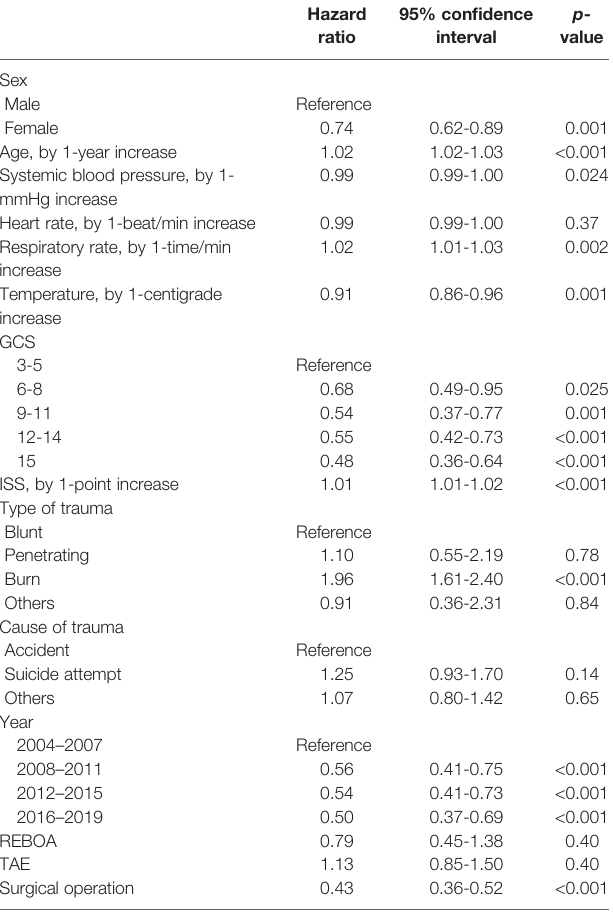
TABLE 2 | Cox proportional hazards regression for in-hospital mortality.